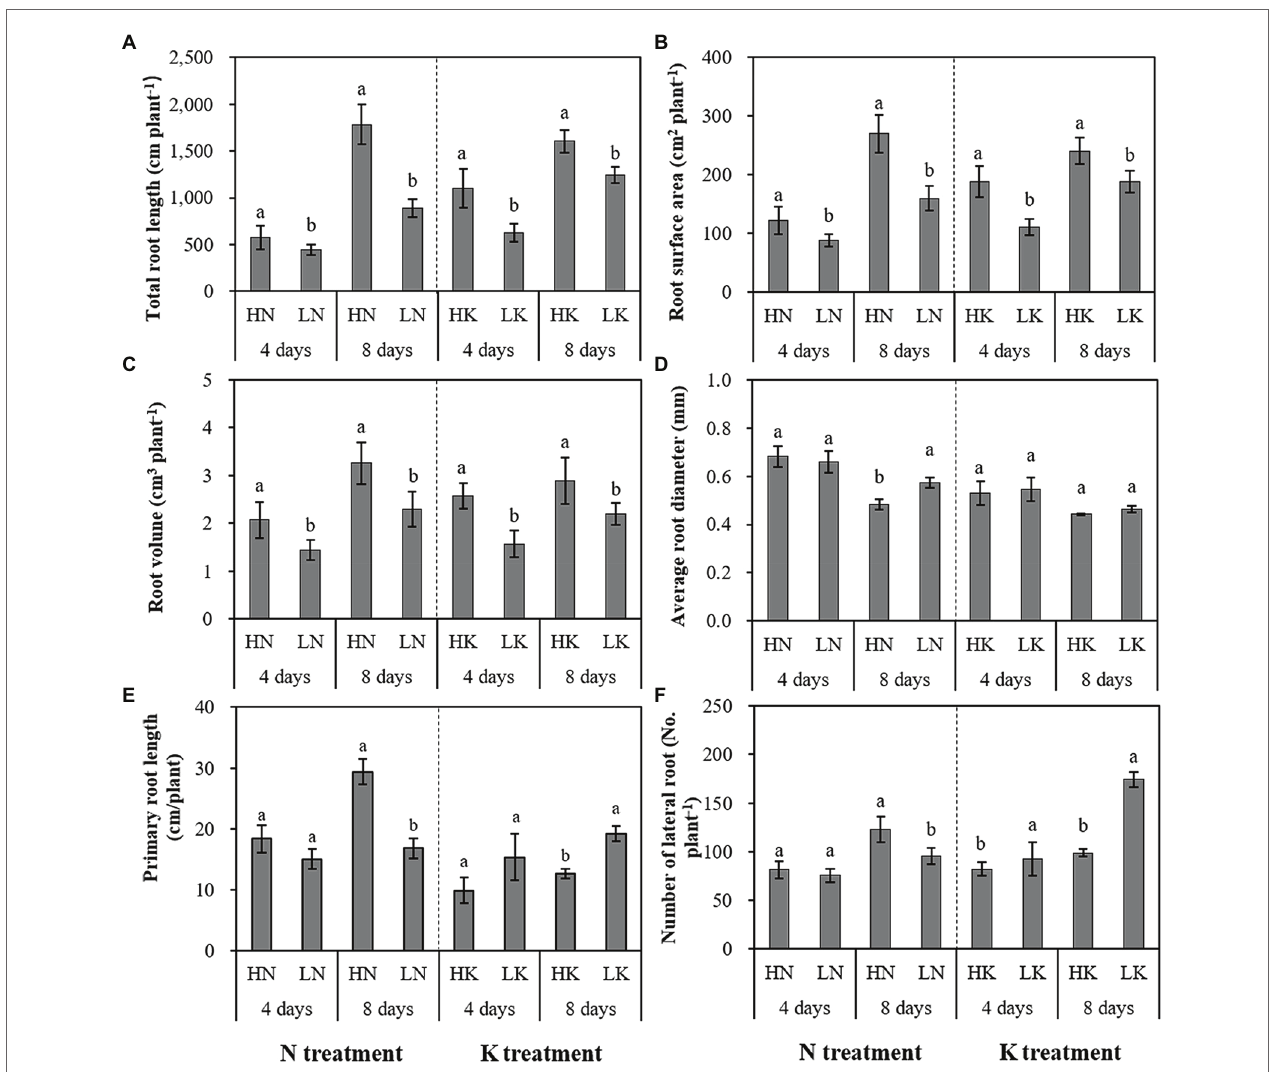
FIGURE 3 | The effect of N deficiency and K deficiency on the total root length (A) , root surface area (B) , root volume (C) , average root diameter (D) , primary root length (E) , and the number of lateral roots (F) of peanut seedlings, respectively. The data are the means ± SDs ( n = 5). The different letters on the bars indicate significant differences between the different N (or K) treatments and the control treatment on the same day according to the LSD test ( p = 0.05). N, nitrogen; K, potassium; and LSD, least significant